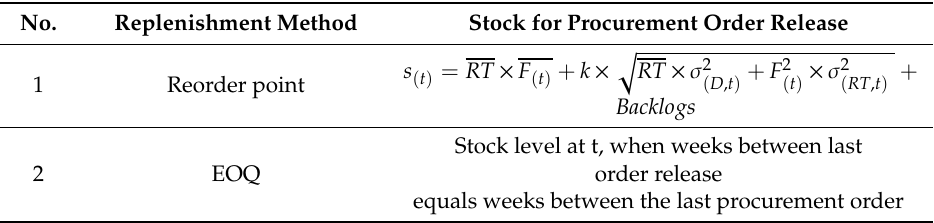
Table 4. Stock for procurement order release (own